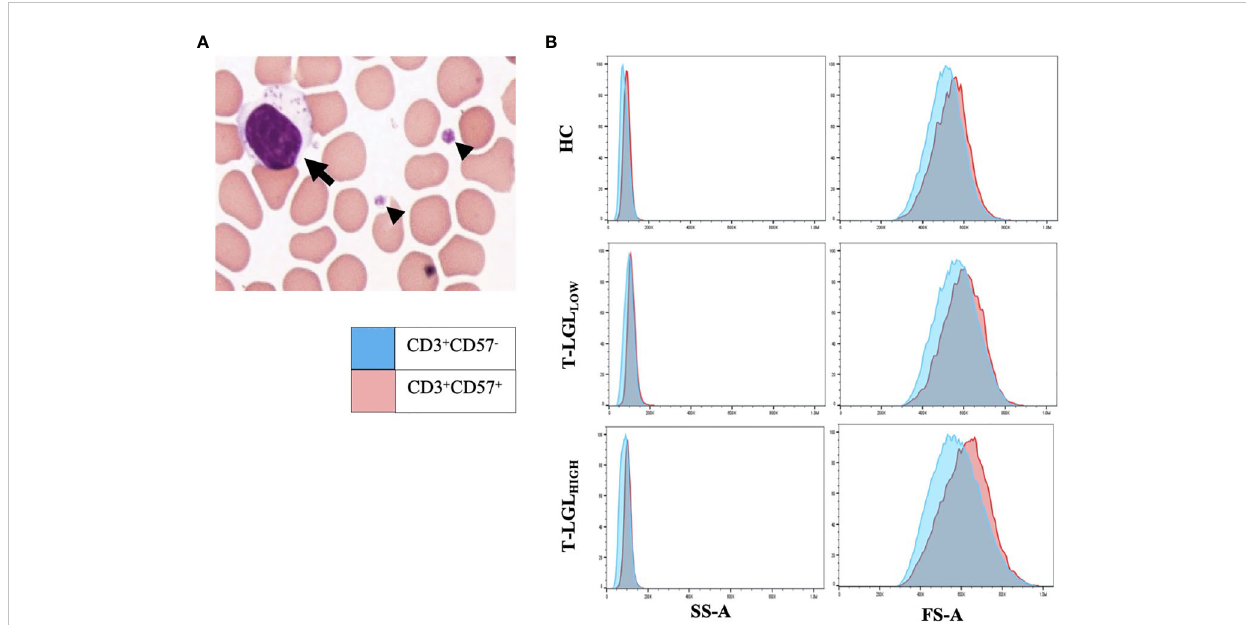
FIGURE 2 LGLs are enlarged cells with granular content. (A) Representative LGL cell showing increased size (15 m m) with multiple cytotoxic granules (arrow). Small arrowheads indicate platelets. The image was taken at 100x magni fi cation. (B) Forward (FS-A) and Side (SS-A) Scatter area measures of representative blood samples from the HC, T-LGL LOW and -HIGH patient groups. Comparative SS-A and FS-A parameter measures are illustrated for the CD3 + CD57 + (red histograms) and the CD3 + CD57 - cells (blue histograms)